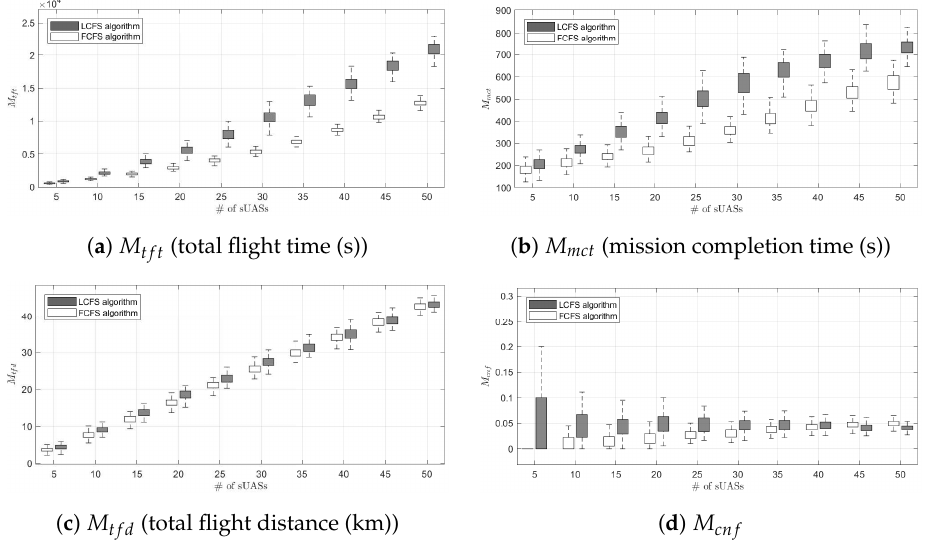
Figure 13. M -to- N Case: Standard deviation comparisons between the FCFS algorithm and the LCFS algorithm for M tft , M mct , M tfd , and M cnf